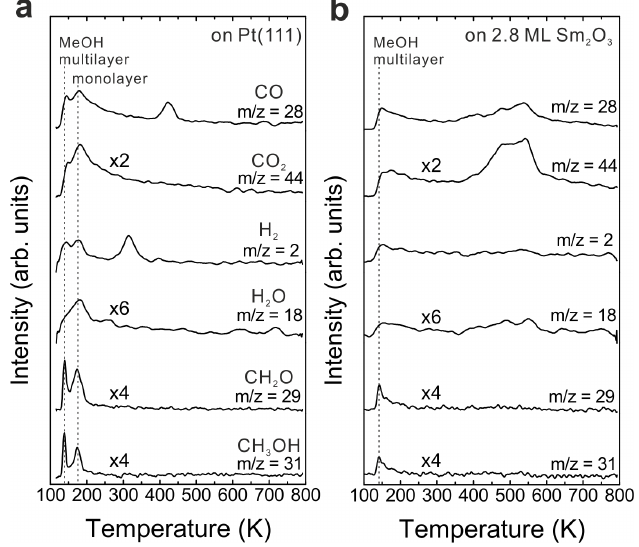
Figure 1. TPD spectra recorded from ( a ) a clean Pt(111) and ( b ) a 2.8 ML as-prepared Sm 2 O 3 thin film.